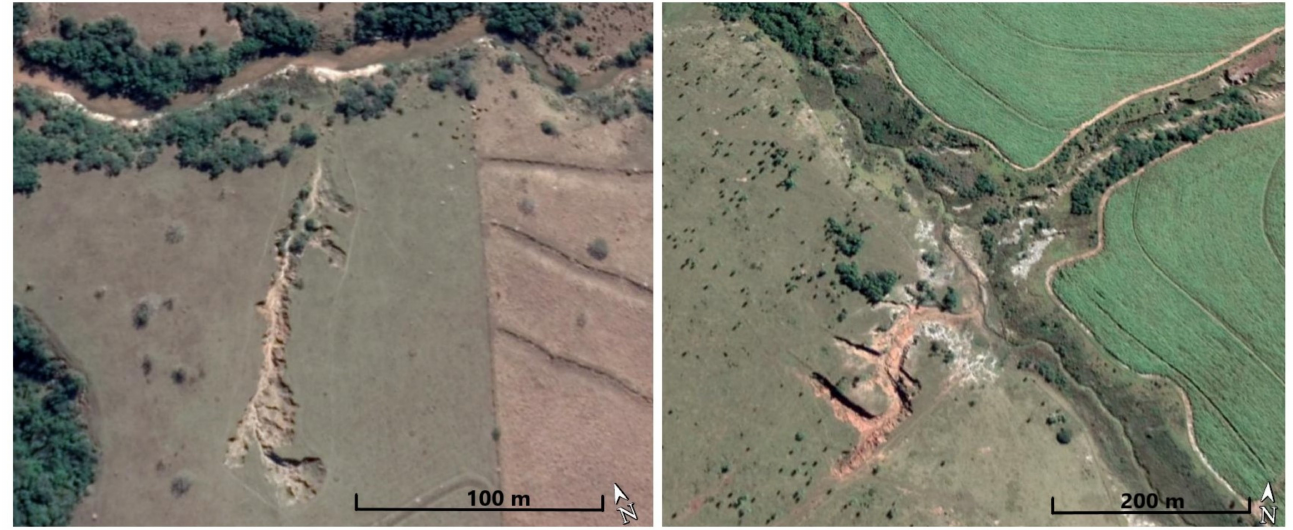
Figure 11. Gully erosion in the eastern parts of the study